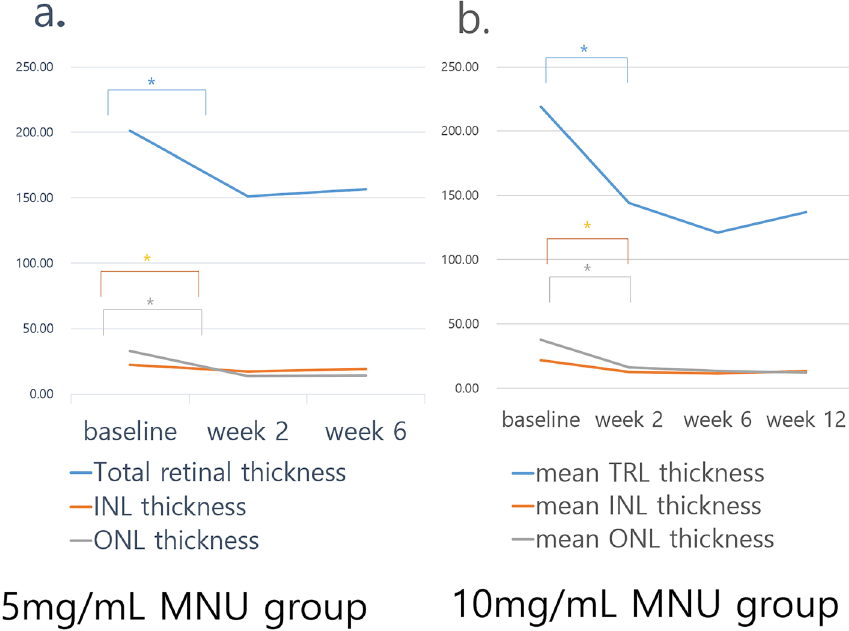
Figure 7. Sequential changes of total retinal thickness, inner nuclear layer thickness, and outer nuclear layer thickness. ( a ) In the 5 mg/mL MNU group, there was a significant decrease in INL, ONL, and total retinal thickness in week 2. After week 2, the subsequent changes were minimal and remained so until week 6. ( b ) In a 10 mg/mL MNU group, there was also a significant decrease of INL, ONL, and total retinal thickness at week 2. After week 2, the subsequent changes were minimal and remained decreased through week 12. TRL total retinal thickness, INL inner nuclear layer, ONL outer nuclear layer, MNU N -methyl- N -nitrosourea).